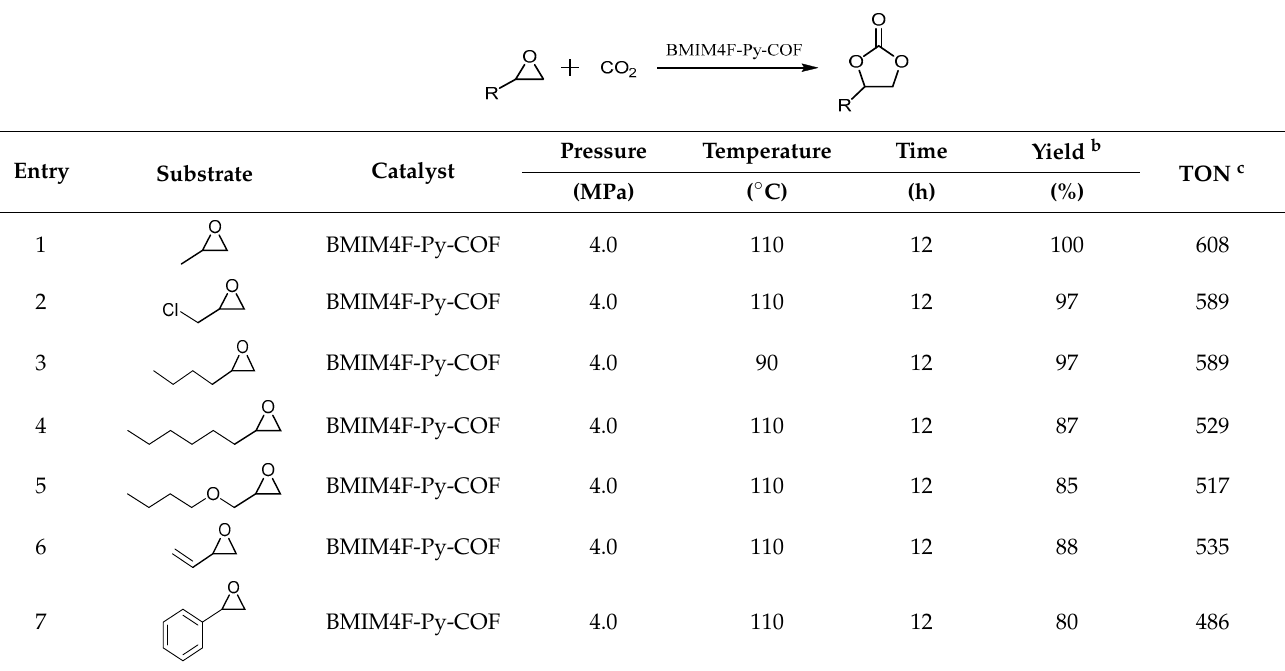
Table 2. Cycloaddition reactions of CO 2 with various epoxides using BMIM4F-Py-COF as catalyst a .